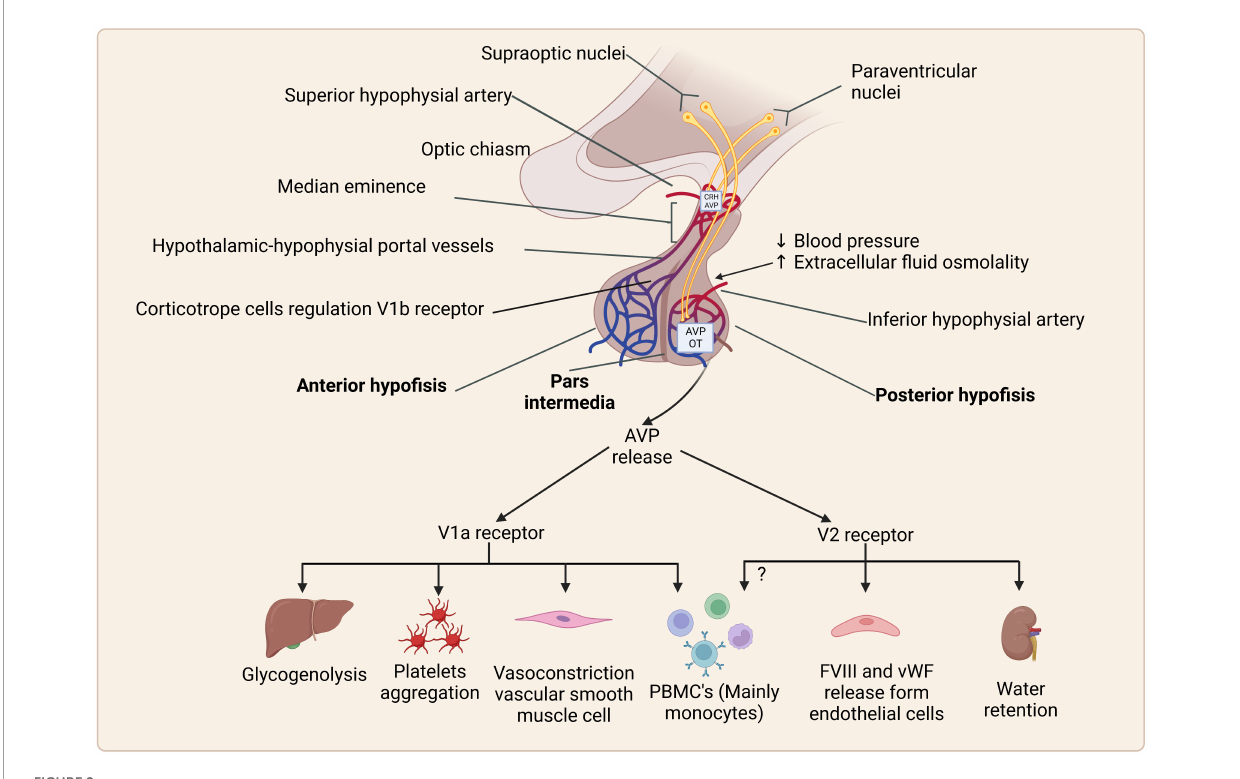
FIGURE2 Schematic representation of synthesis, storage, and effects of arginine vasopressin (AVP) via AVP receptors and their expression. Created with